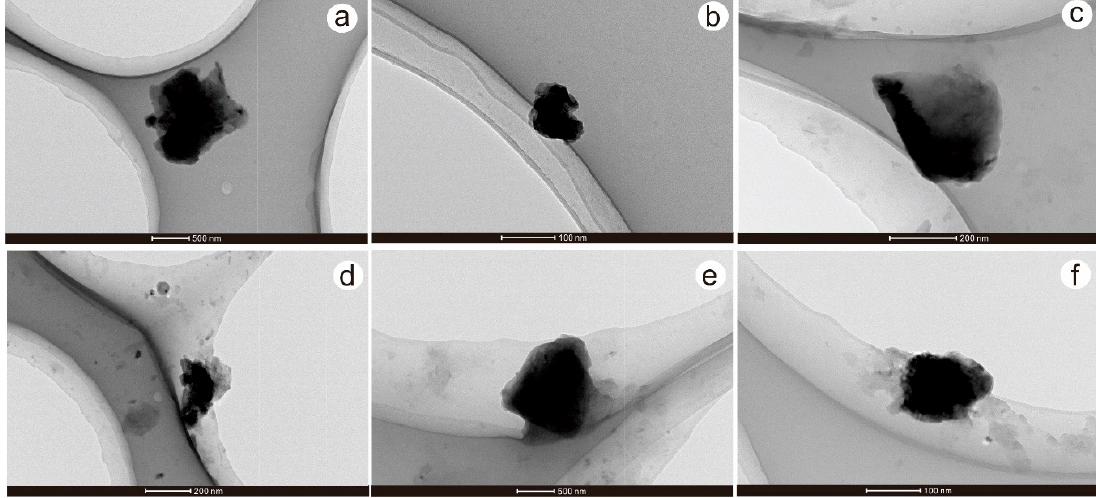
Figure 10. Cu-, Pb-, and Zn-bearing nanoparticles in fault gouges; ( a ) TEM image of a Cu-bearing particle; ( b ) TEM image of a Zn-bearing particle; ( c ) TEM image of a Zn-bearing particle; ( d ) TEM image of a Pb-bearing particle; ( e ) TEM image of a Pb-bearing particle; ( f ) TEM image of a Pb-bearing particle.